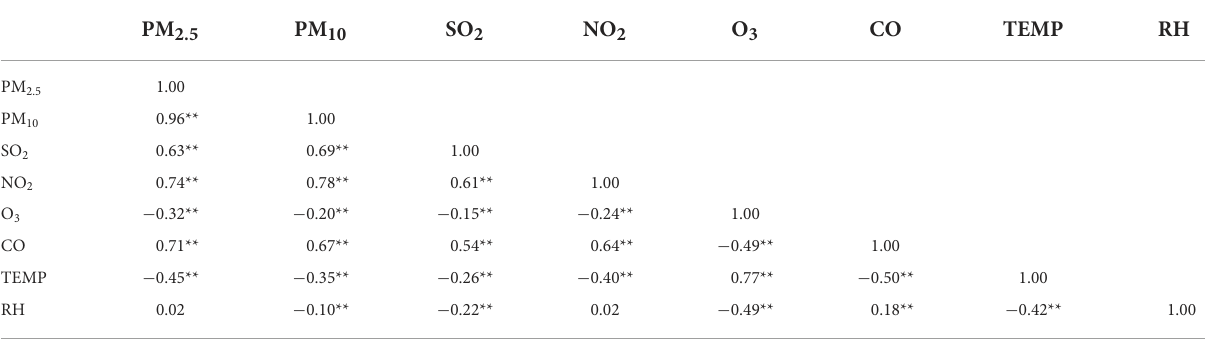
TABLE 2 Spearman’s correlation between daily mean air pollutants concentrations and meteorological factors in Chongqing, China. PM 2.5 PM